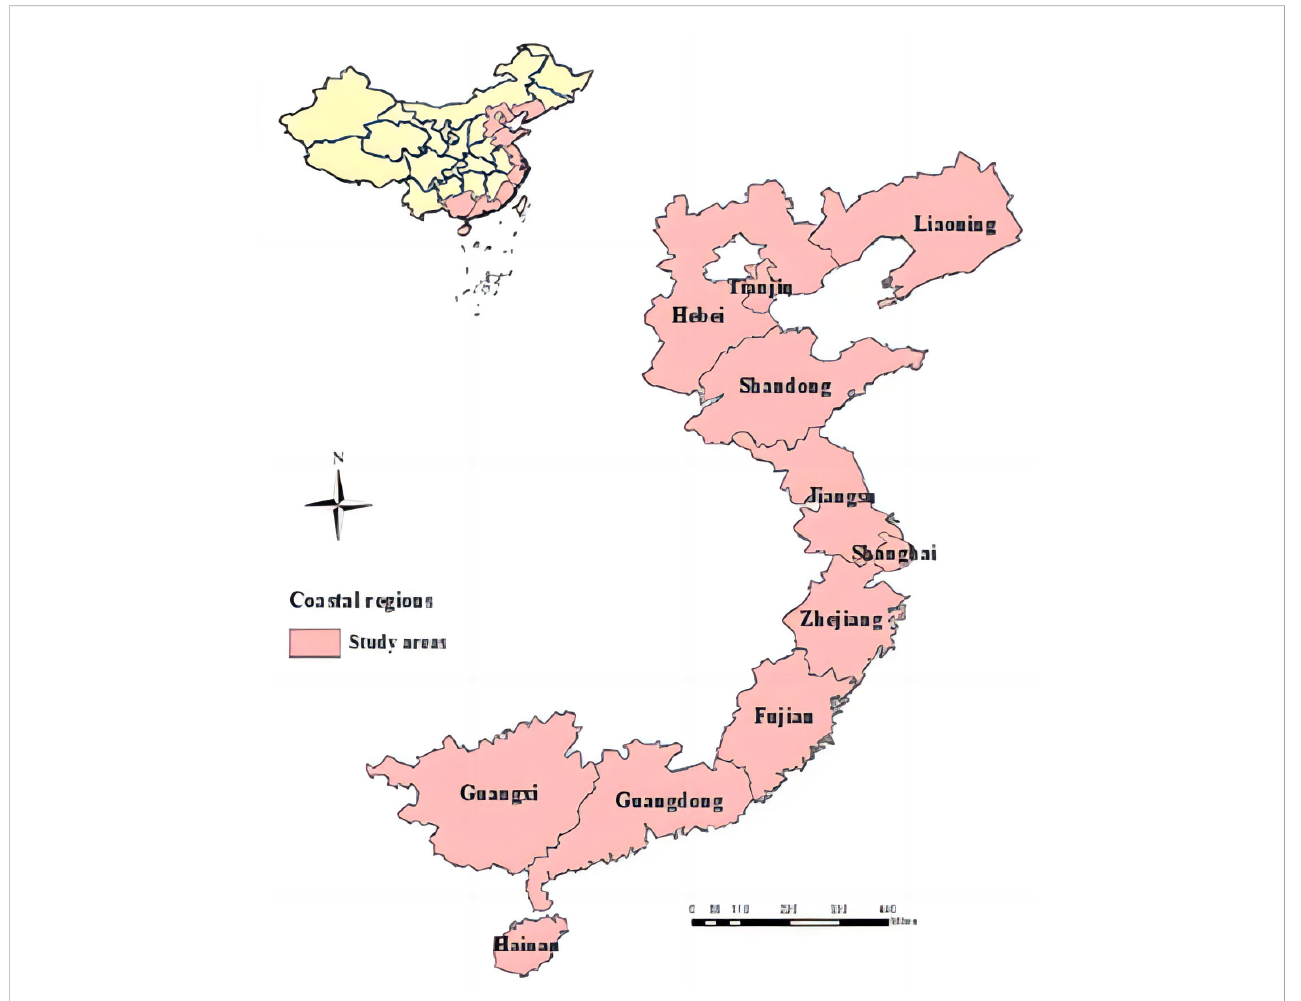
FIGURE 1 Coastal regions in